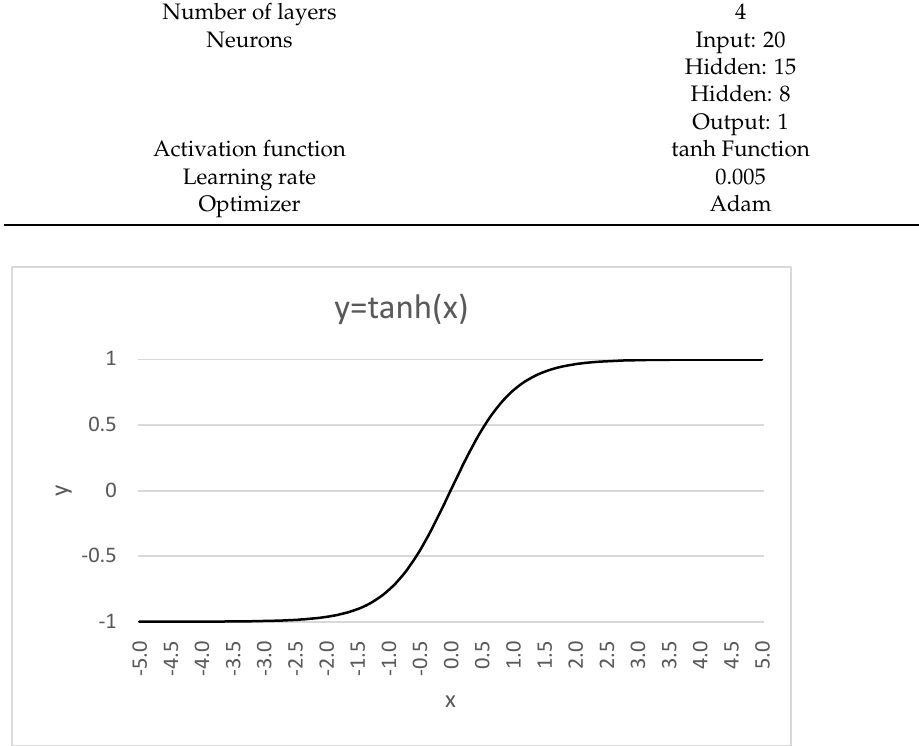
Figure 7. tanh Function.